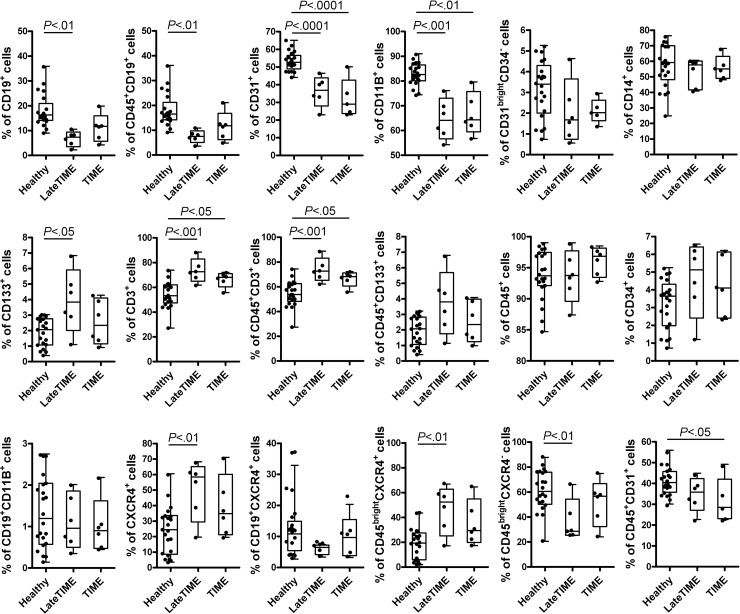
Changes in BM MNC composition in the patients from TIME and LateTIME trials whose cells were used for implantation.MNC samples from TIME (n = 6) and LateTIME (n = 6) were quantitatively analyzed by flow cytometry and compared to healthy MNC samples (n = 22). The main findings were that TIME and LateTIME MNC samples contained fewer CD19+ cells (barely missing significance at P = 0.057 for TIME), CD31+ cells, and CD11B+ cells, and more CD3+ cells, than healthy MNC samples. There were more CD133+, CXCR4+ and CD45brightCXCR4+ cells in LateTIME MNC samples relative to healthy and TIME MNCs.